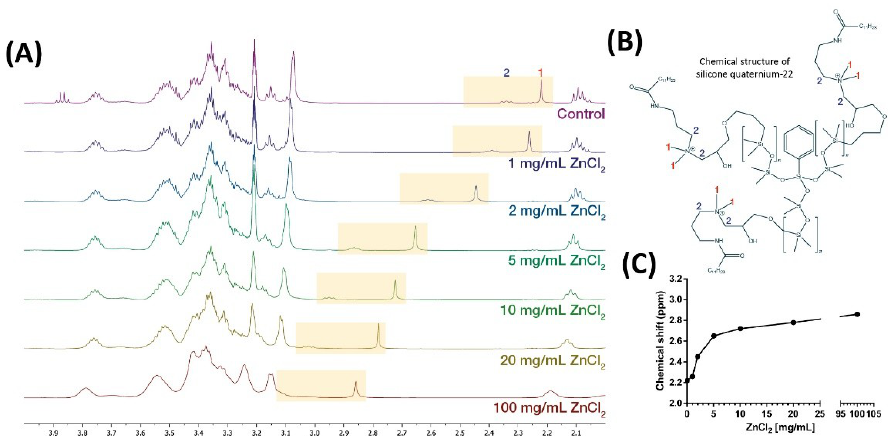
Figure 6. 1 H NMR titration study with 20% ABIL T Quat 60 and zinc chloride (1–100 mg/mL) in CD 3 OD. 1 and 2 represented the methyl group and the alkyl chain next to the amine group of ABIL. ( A ) Chemical shift induced by the chelation of zinc ion; ( B ) Chemical structure of ABIL; ( C ) Titration curve of the methyl group (1) of the amine group.